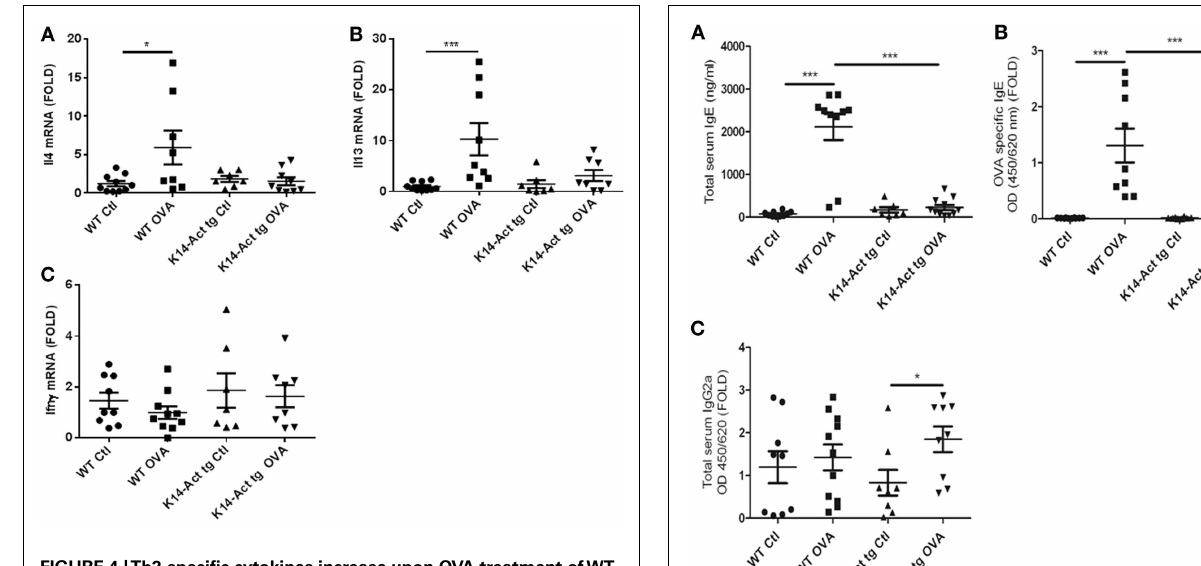
FIGURE 4 |Th2-specific cytokines increase upon OVA treatment ofWT mice but not of K14-Act mice . Skin biopsies fromWT and K14-Act mice, untreated or treated (vehicle-Ctl or OVA) were collected and used for RNA isolation and subsequent generation of cDNA. Real-time PCRs were performed using primers specific for (A) mIl13 , (B) mIl4 , and (C) mIfn γ . Ct values were normalized to expression levels of the hprt house-keeping gene.The experiment was realized in groups of 8–10 mice. Results are presented in a scatter graph and mean values ± SEM are shown. Statistically significant differences were calculated with the Mann–Whitney U -test ( p < 0.05*, p < 0.01**, and p < 0.001***).